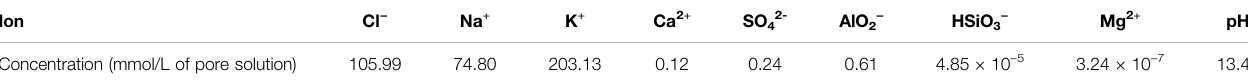
TABLE 5 | Ionic concentration and pH of pore solution.